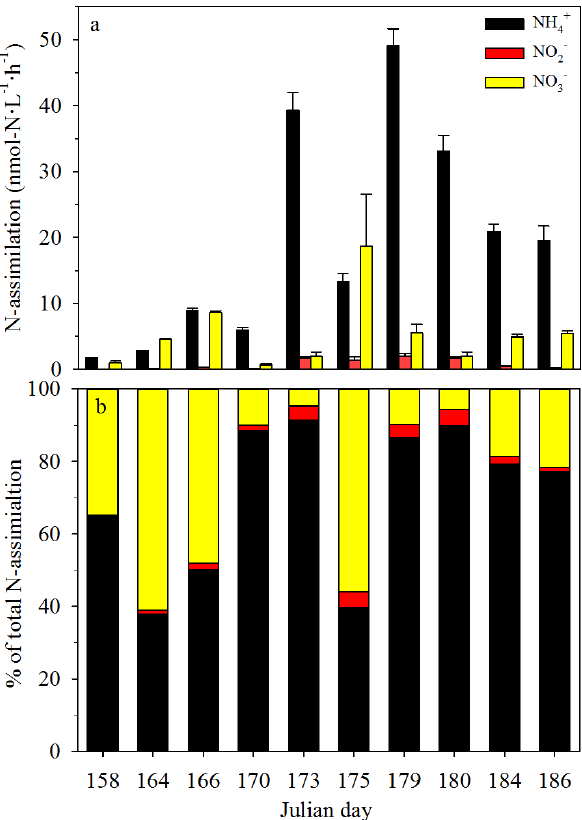
Figure 4. The rate of NH + termined at observational stations identified in Fig. 1, and the con- tribution (in %) that each inorganic nitrogen source makes to total N-assimilation (b)